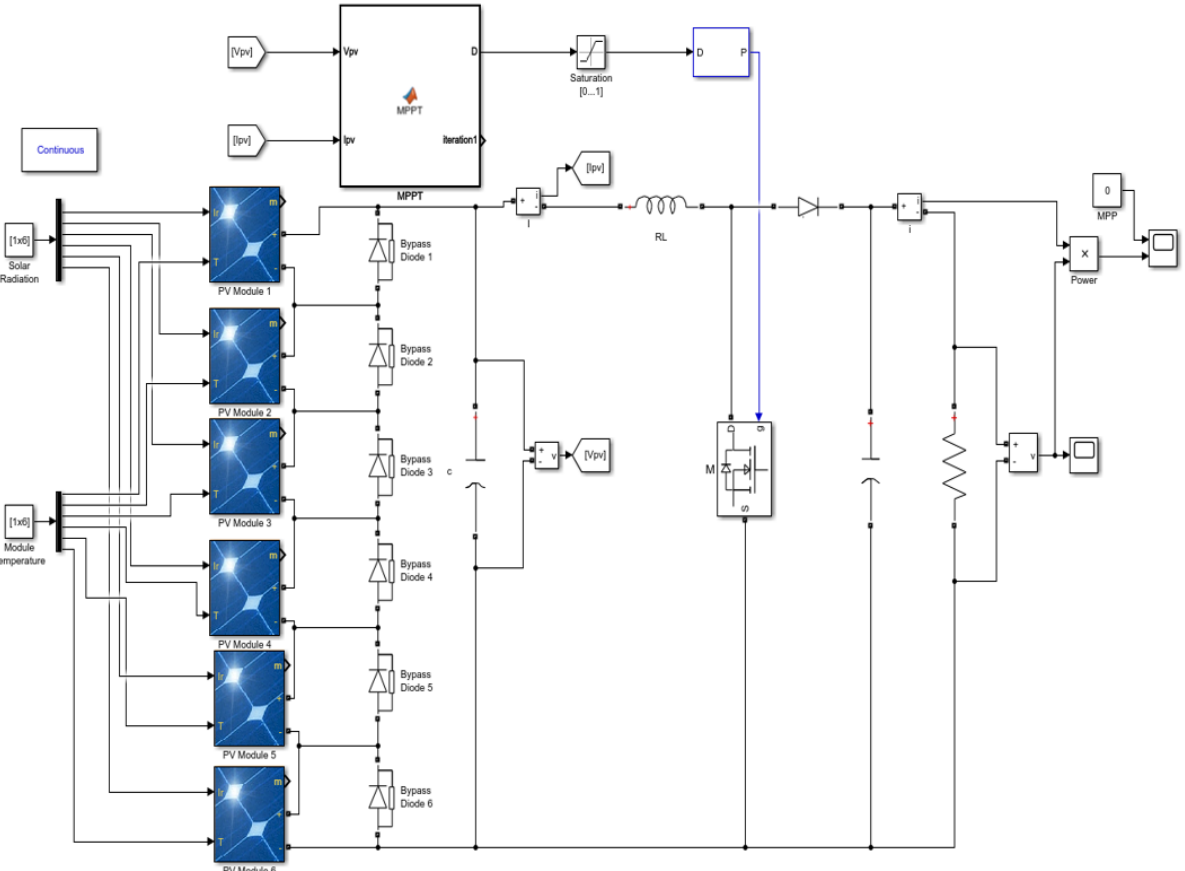
Figure 7. MATLAB - Simulink image of the designed system. Figure 7. MATLAB-Simulink image of the designed